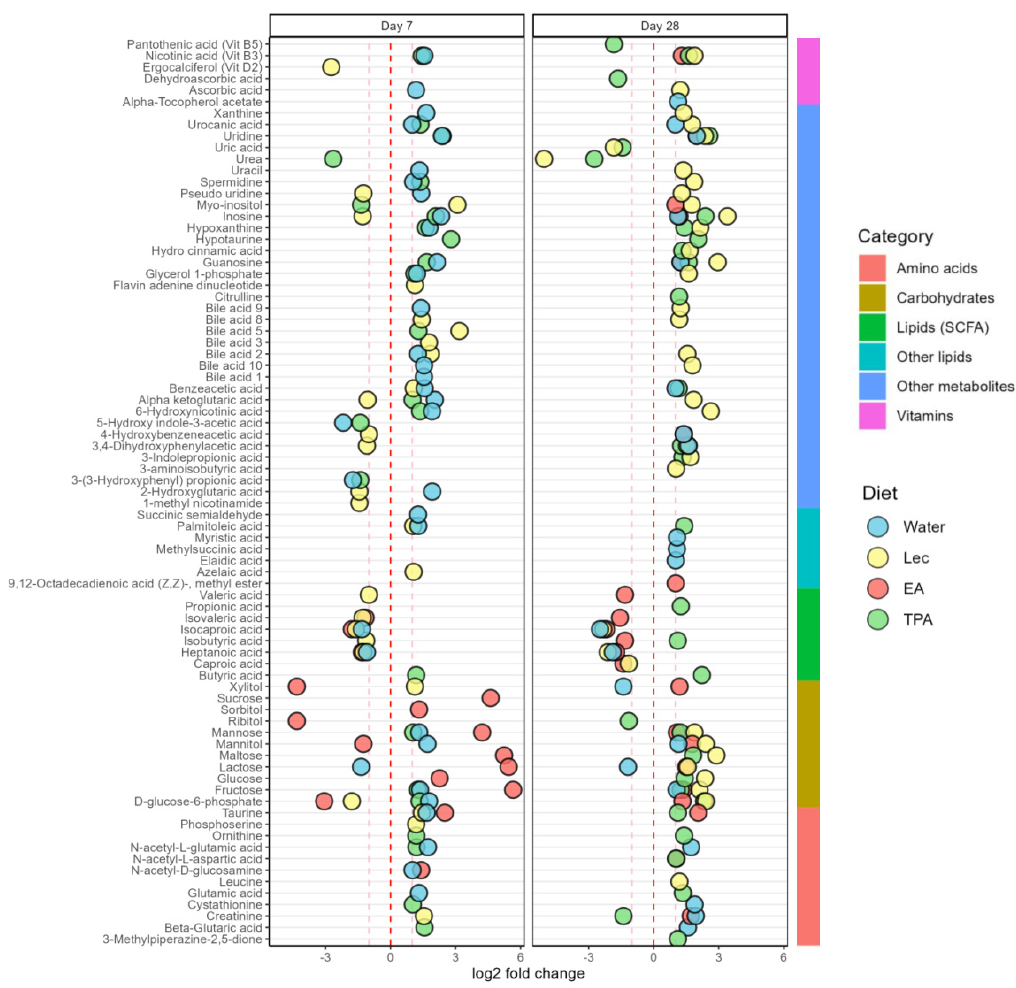
Figure 5. Fold changes for semiquantitative (SQ) lipids, carbohydrates, amino acids, vitamins and derivatives, bile acids, purine compounds, and other organic metabolites after lecithin, EA, TPA, and water intake after 7 and 28 days. Zero shows the direction of change, and lines at 1 and − 1 represent a doubling or halving in metabolite abundance. Changes in all values are significant compared to day 0 ( p < 0.05). (Fold-change values are presented in Tables S1 and S2 and fold-change for quantitative values for is shown Figure